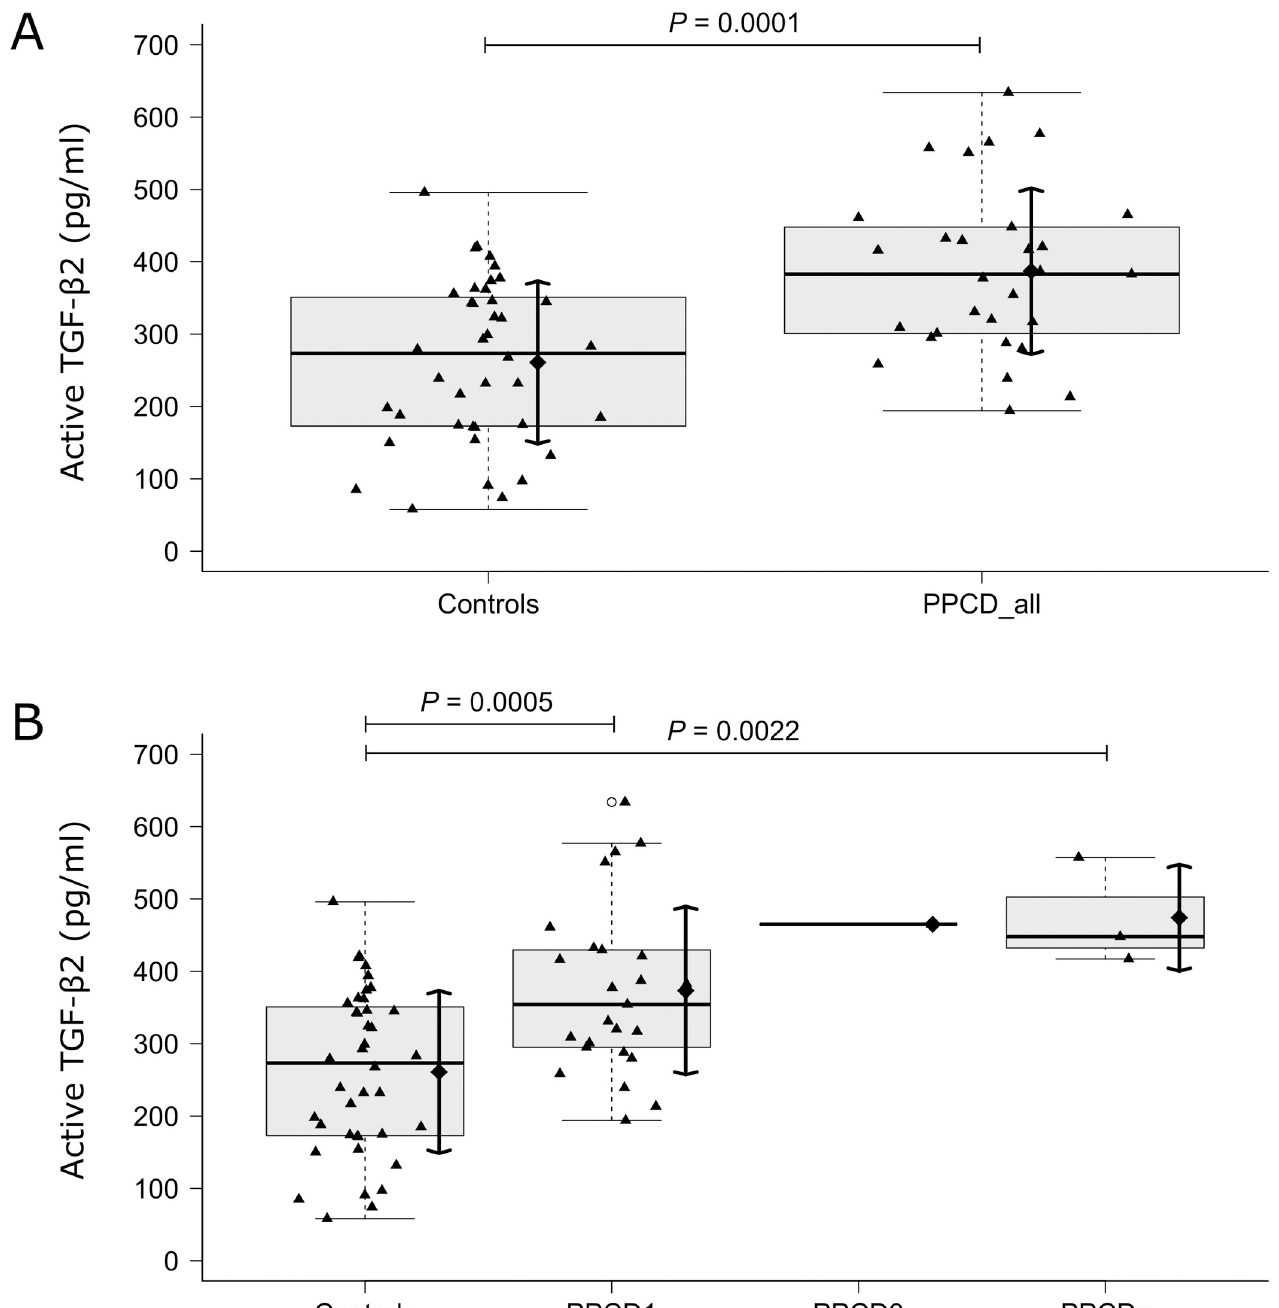
Fig 1. Active transforming growth factor (TGF)- β 2 levels in the AH measuredby ELISA. (A) Distributionof the active TGF- β 2 levels in the AH of controls and all posterior polymorphous corneal dystrophy patients (PPCD_all), and (B) of controls and the groupsof patients with different moleculargeneticcauses: PPCD1, PPCD3, and PPCDx. Multipledata points from the same patient were averagedand the averagevalue presented as one data point. Active TGF- β 2 levels are presented as data distributionand box plots enhanced with mean ± SD. Displayed P -values reflect statistical significanceof observed differences in the mean values of TGF- β 2 obtainedas fixed effects in otherwiseunadjustedlinear mixed- effects model.